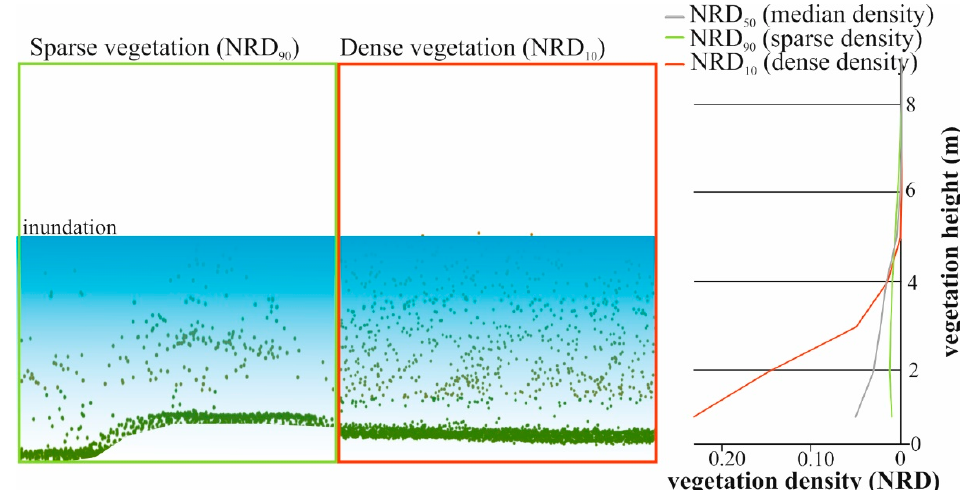
Figure 9. LiDAR point distribution in voxels with sparsely and densely vegetated Amorpha thickets, and characteristic vertical distribution of their vegetation density.